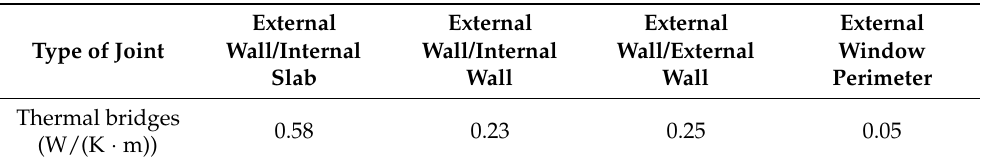
Table 2. The linear heat loss coefficient of thermal bridges (W/(K · m)) for different types of joints in the building [34].